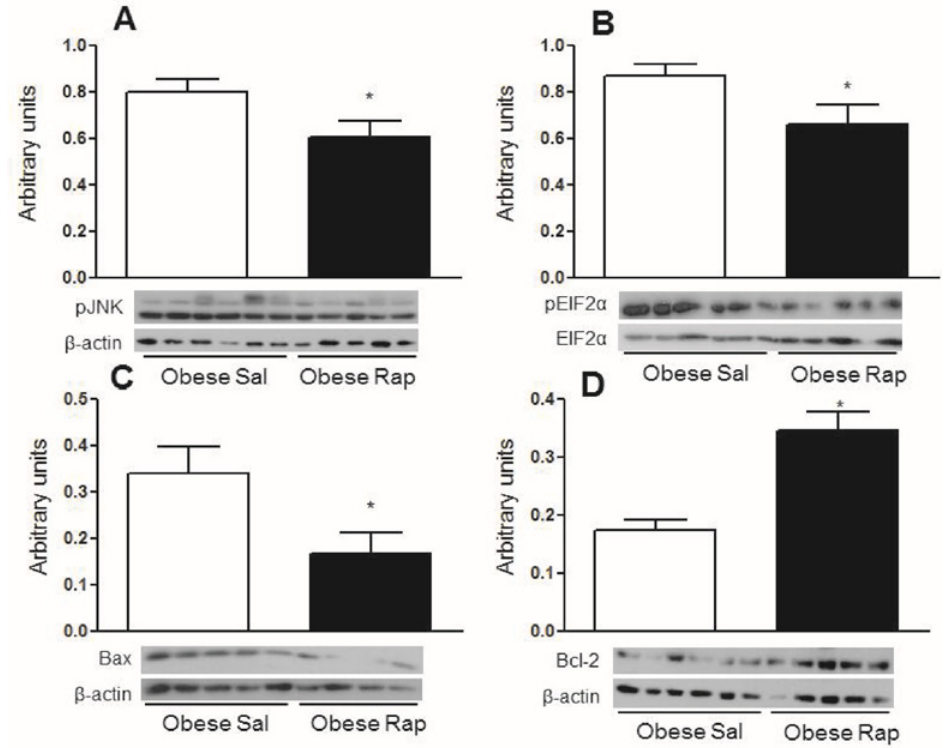
Fig 7. Rapamycin treatment decreases inflammation, endoplasmic reticulum stress and apoptosis markers in obese mice. A and B. Western blotting of pJNK and pEIF2 α content in the hypothalamus of obese mice (16 weeks on a HFD) treated (once per day) for 5 days with 2 μ l of a solution that contained 25 μ M rapamycin (Rap) or saline (Sal). C and D. Bax and Bcl-2 content in hypothalamus of obese mice treated with rapamycin. Values are shown as mean ± SEM. * P < 0.05; n = 5 – 6 animals per group.